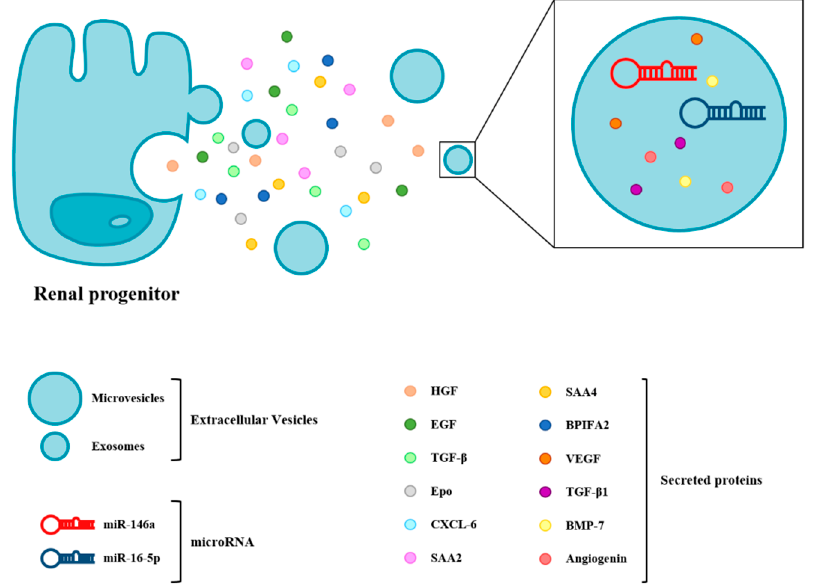
Figure 2. Adult kidney progenitor cells secrete soluble molecules, as well as molecule-containing extracellular vesicles, that contribute to the regeneration of the kidneys. miR: microRNA, HGF: hepatocyte growth factor, EGF: epidermal growth factor, TGF- β : transforming growth factor- β , Epo: erythropoietin, CXCL6: C-X-C motif chemokine ligand 6, SAA2: serum amyloid A2, SAA4: serum amyloid A4, BPIFA2: BPI (bactericidal permeability-increasing) fold-containing family A member 2, VEGF: vascular endothelial growth factor and BMP-7: bone morphogenetic protein 7.